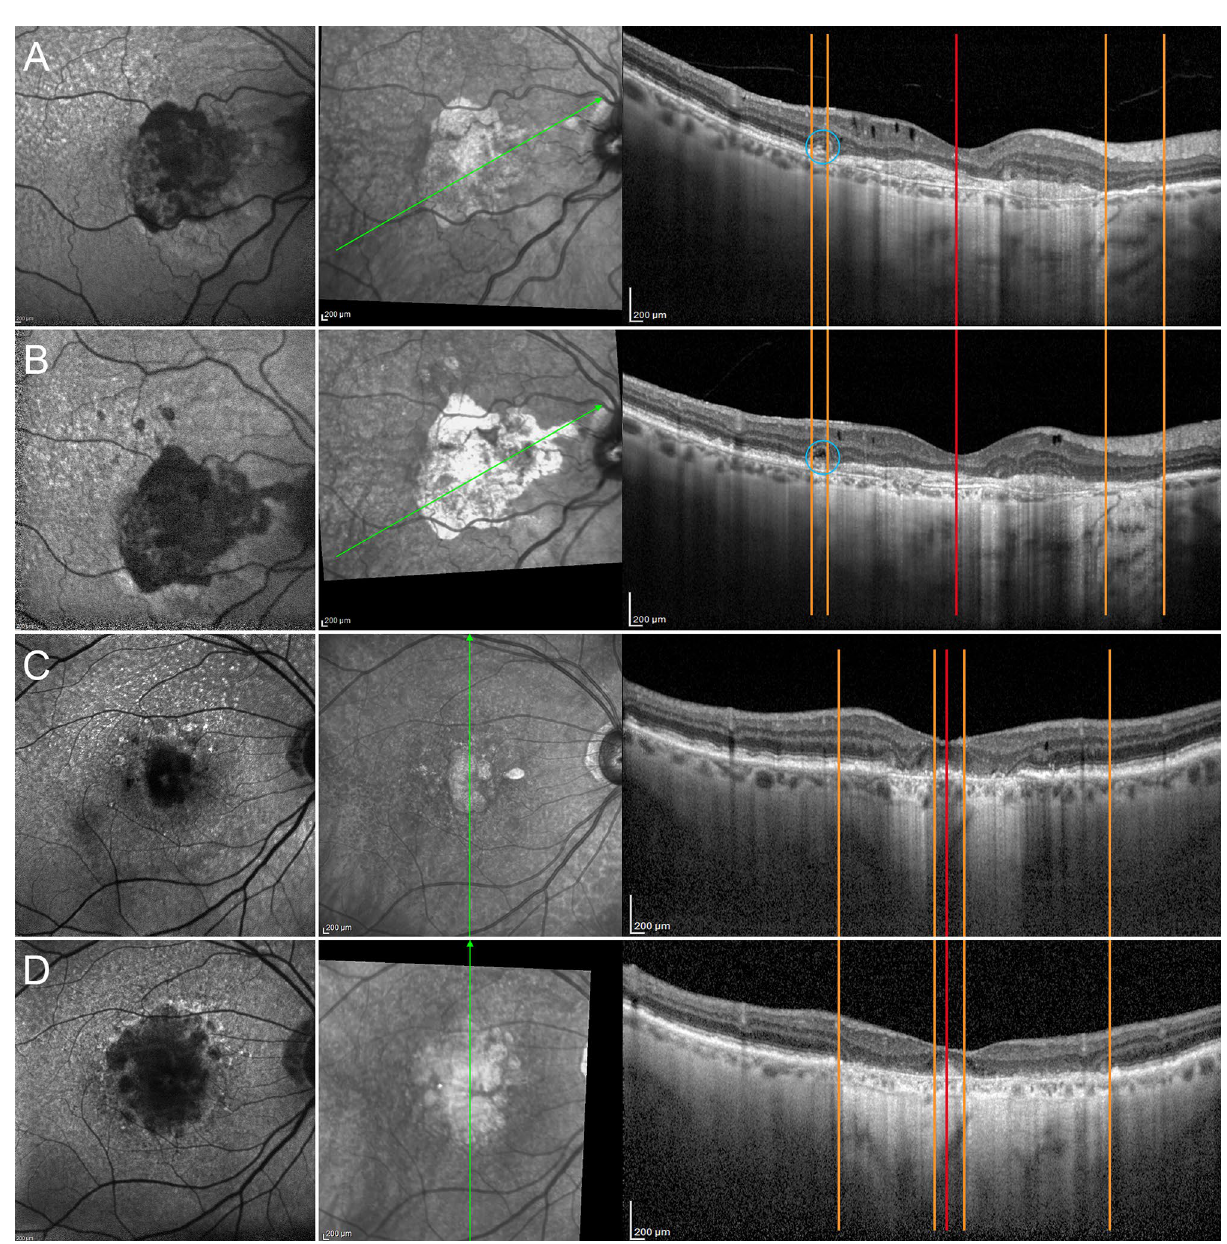
Figure 4. The effect of ORT on the linear expansion of the outer retinal atrophy. In the first case, the onset of ORT (blue circle) ( A ) is associated with an asymmetric linear expansion of the outer retinal atrophy, included between orange lines, revealing itself to be considerably smaller on the side of the ORT, compared with the contralateral side ( B ). In contrast, a case with no onset of ORT shows an almost symmetric progression of the outer retinal atrophy over the follow-up ( C and D ,